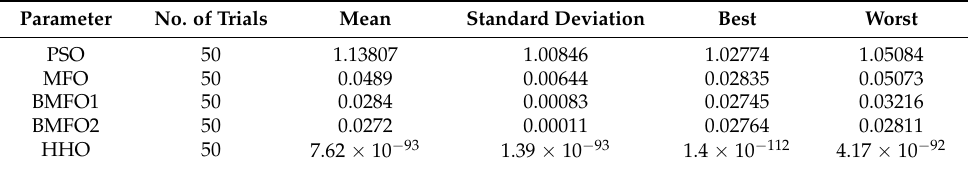
Table 1. Performance of various algorithms in the proposed system.